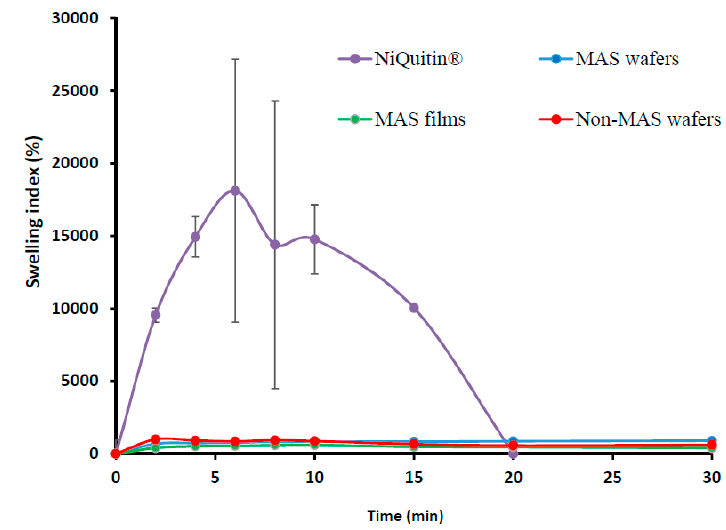
Figure 2. Swelling profile (i.e., % swelling index against time) ( n = 3, ± SD) of NiQuitin ® , HPMC–SA wafers, and films.